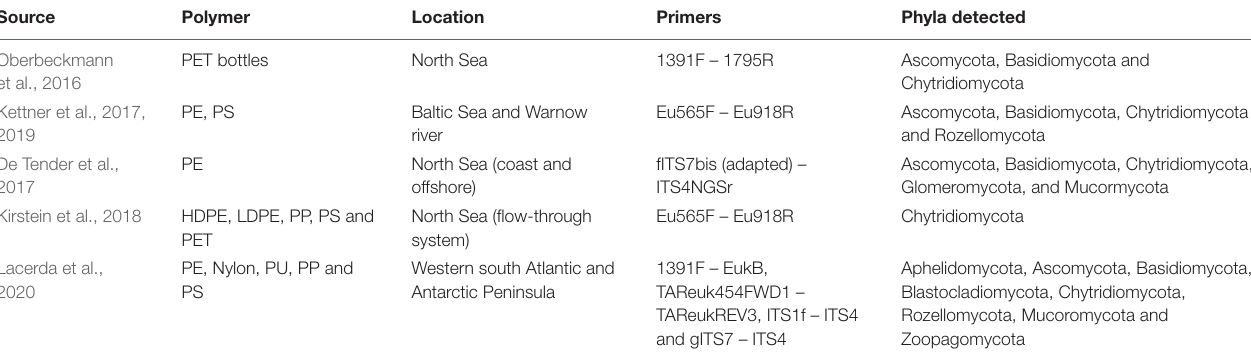
TABLE 1 | Studies on the diversity of fungal communities on microplastics in marine